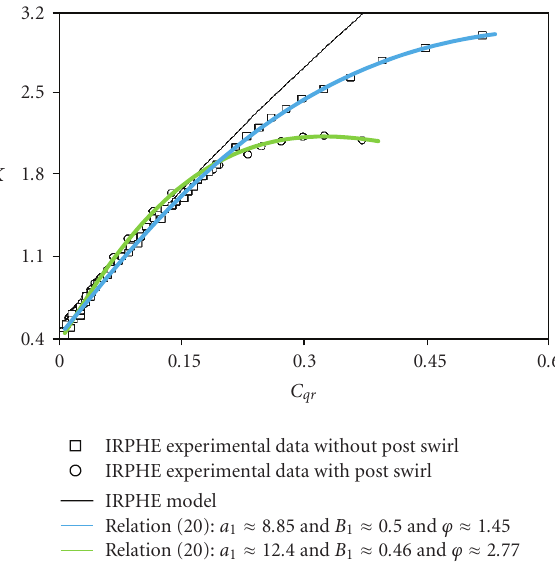
Experimental data for test case A Experimental data for test case B Experimental data for test case C Figure 15: Radial pressure distribution computed with (11).